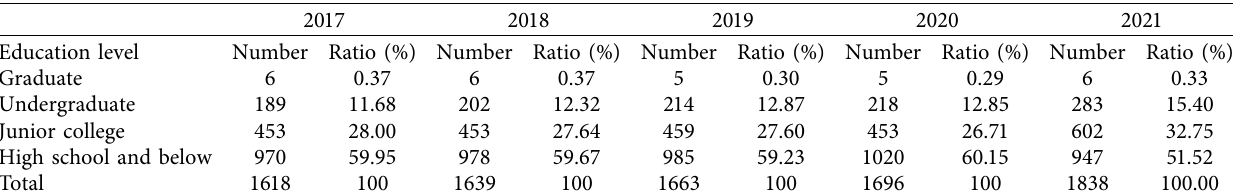
Table 15: Educational background of employees in Y